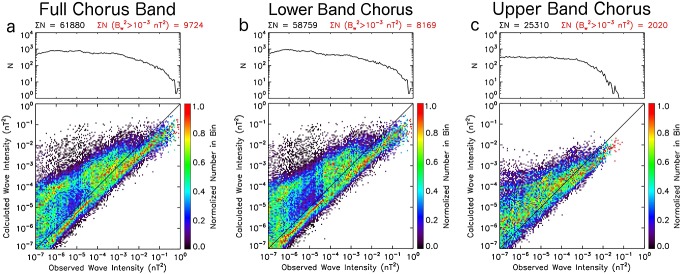
(a) Plot showing how the observed wave intensity from Van Allen Probe A compares with that calculated using the cold plasma dispersion relation in the 0.1 to 0.9 fce range for the 20 day sample period used in this study. The color indicates the number of occurrences in each bin, normalized to the number of occurrences in each observed wave intensity column. The line plot above each panel indicates the number of occurrences in each observed wave intensity column, in addition to listing the total number of occurrences (ΣN) and the number of occurrences with high observed wave intensity (ΣN ()). The same quantities calculated separately for (b) lower band (0.1 to 0.5 fce) and (c) upper band (0.5 to 0.9 fce) chorus frequencies.